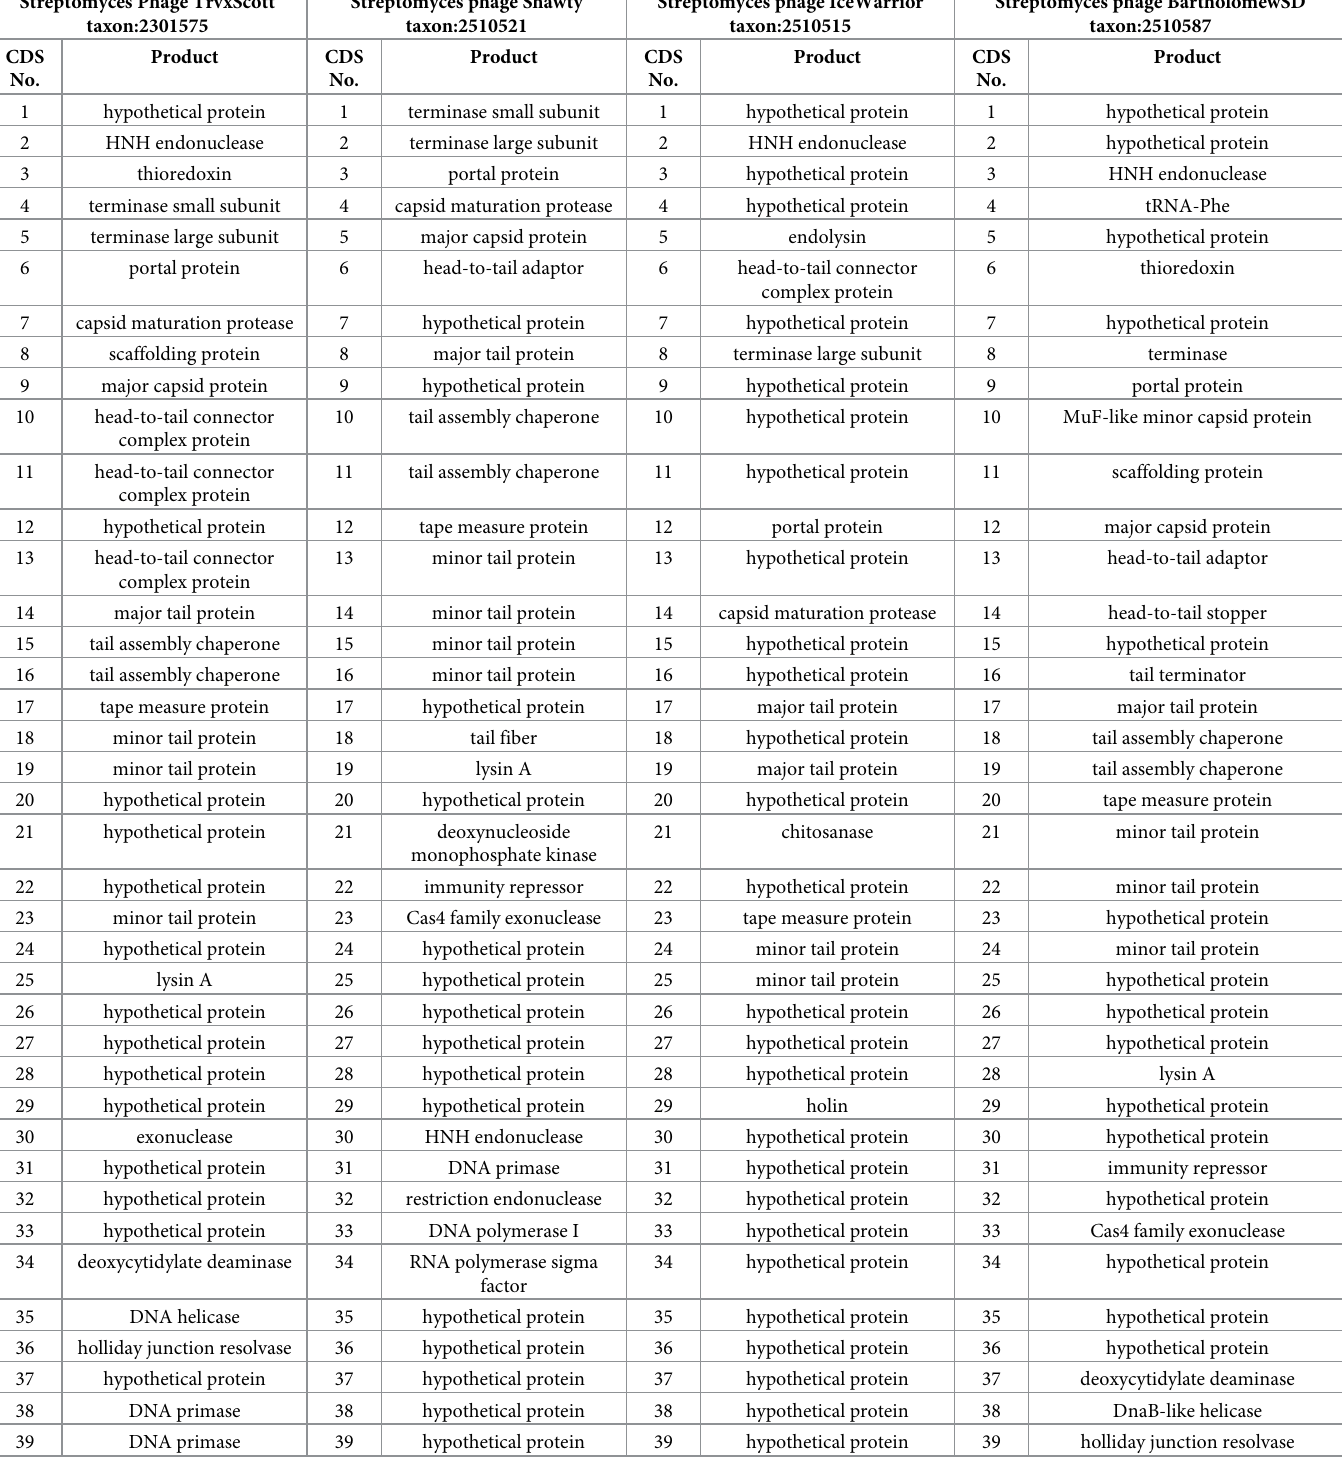
Table 8. Functions of the putative proteins encoded within the genomes of four phage isolates. Streptomyces Phage TrvxScott Streptomyces phage Shawty taxon:2301575